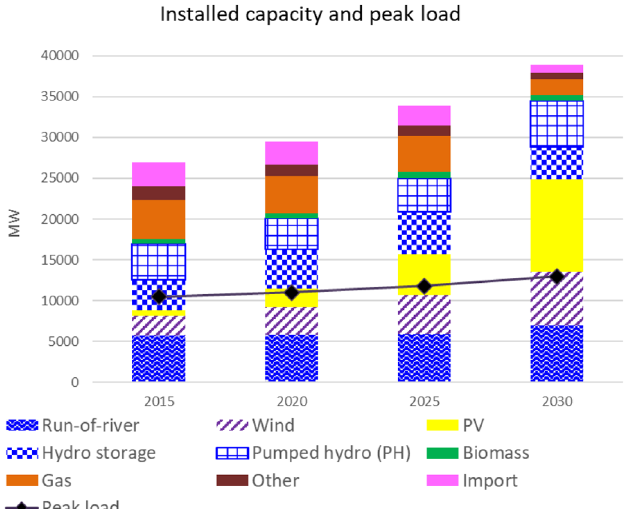
Fig. 6. Development of installed capacities und yearly peak load (in MW) in the BAU-scenario from 2015 to 2030 in Austria (incl. capacities of hydro